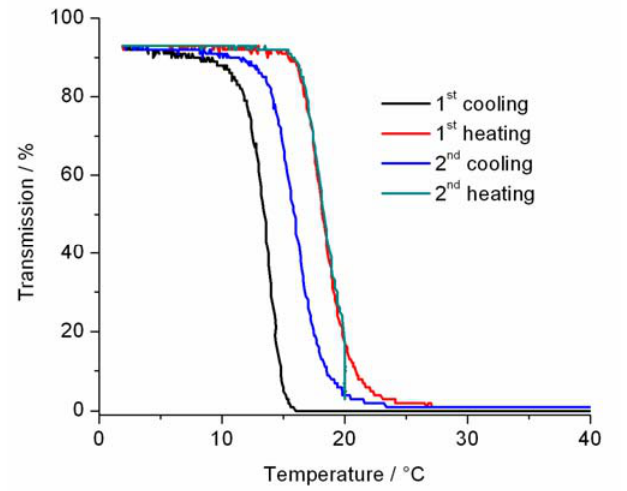
Figure 2. Turbidity versus temperature plot for an aqueous solution of copolymer 5 (2.5 mg mL − 1